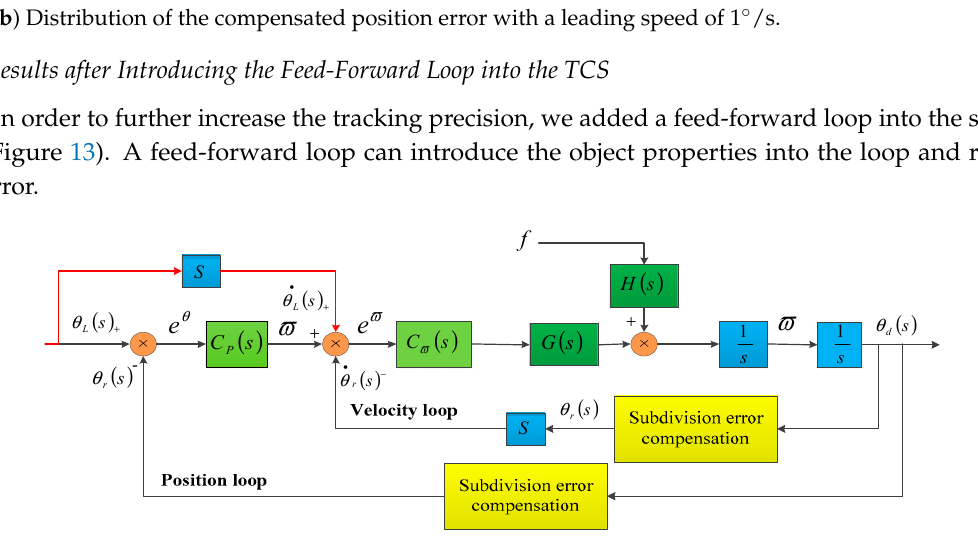
Figure 13. Adding a feed-forward loop into the control system. After adding the feed-forward loop, the RMS of the position errors were Error v = 0.25 = 1.05 (cid:48)(cid:48) and Error v = 1 = 1.79 (cid:48)(cid:48) . The feed-forward loop further decreased the previously compensated errors of about 9.5% and 6.8%. Because of the characteristics of the feed-forward loop, if the frequency of the error was lower, the error decrease would be greater [16]. The distribution of the error after adding the feed-forward loop was as follows (Figure